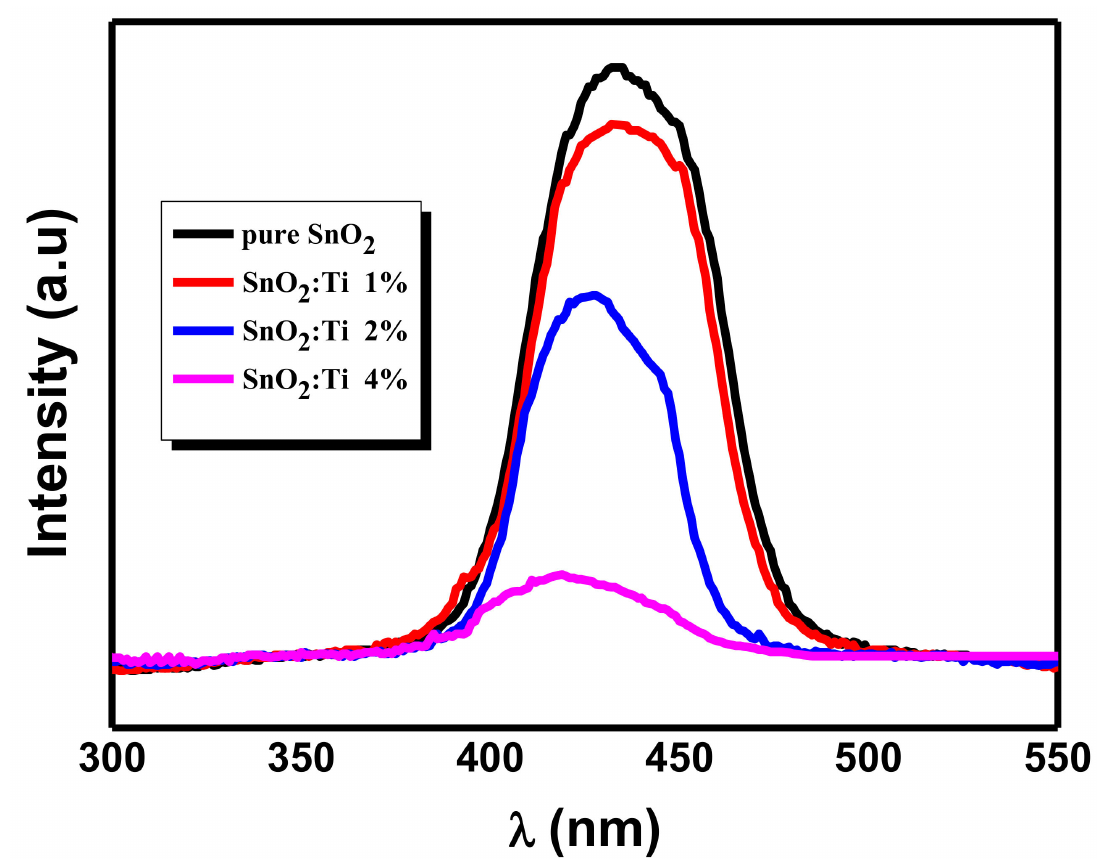
Figure 12. Photoluminescence spectra of Ti–SnO 2 based